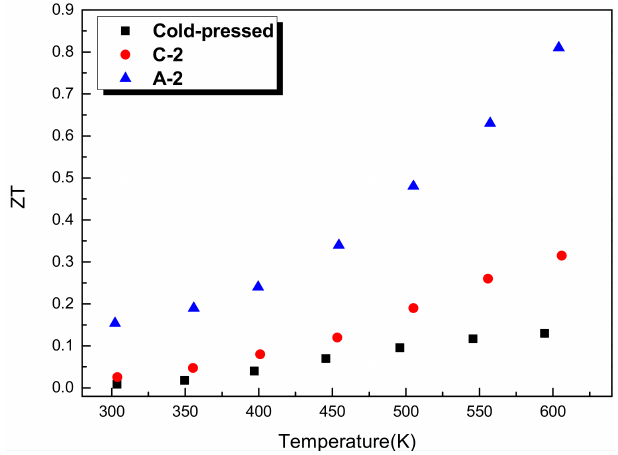
Figure 11. Variation of the thermal conductivity as a function of temperature for the hot pressed Zn 4 Sb 3 specimens.